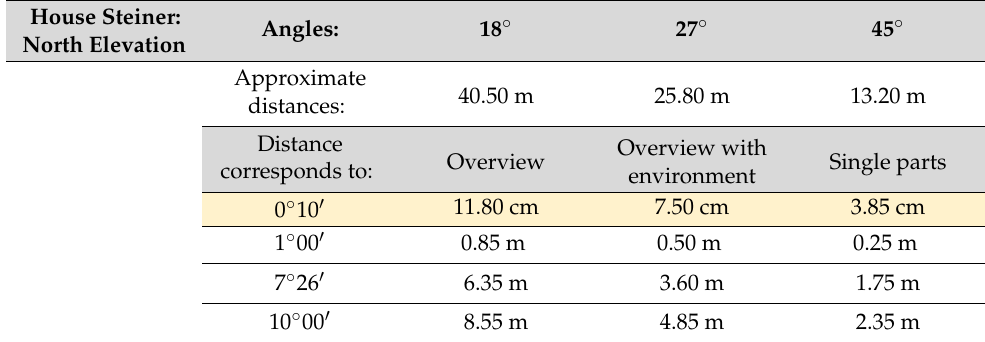
Table 1. Calculation of the box sizes depending on the building height and the distance for the north view of House Steiner.